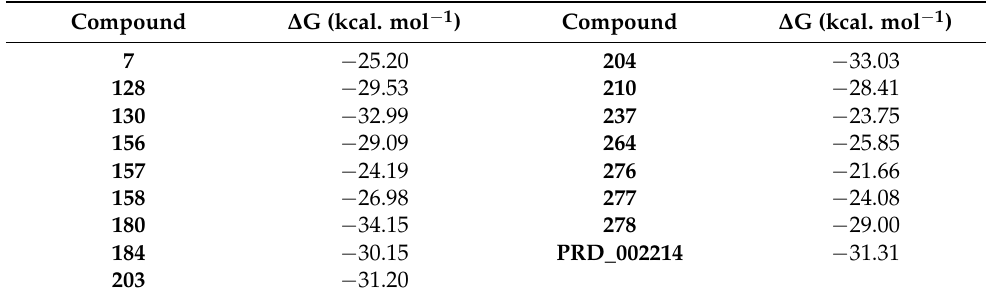
Table 4. The computed values of ∆ G of the antiviral compounds and the co-crystallized ligand against M pro . Compound ∆ G (kcal. mol − 1 )